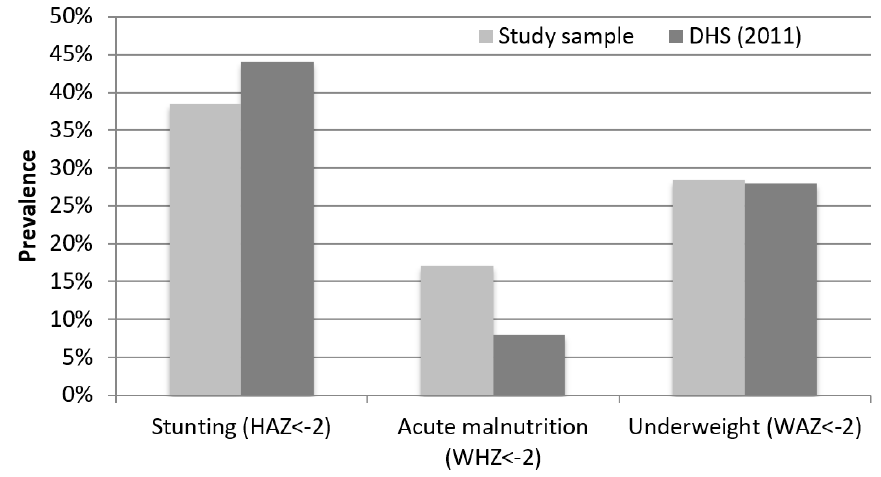
Figure 1. Child nutritional status at the first assessment (post-harvest, n = 218), compared with children under five years in the Southern Nations, Nationalities, and Peoples’ Region (SNNPR) reported in the 2011 Ethiopia Demographic and Health Survey (DHS) [14]. HAZ: height-for-age z-score; WHZ: weight-for-height z-score; WAZ: weight-for-age z-score.